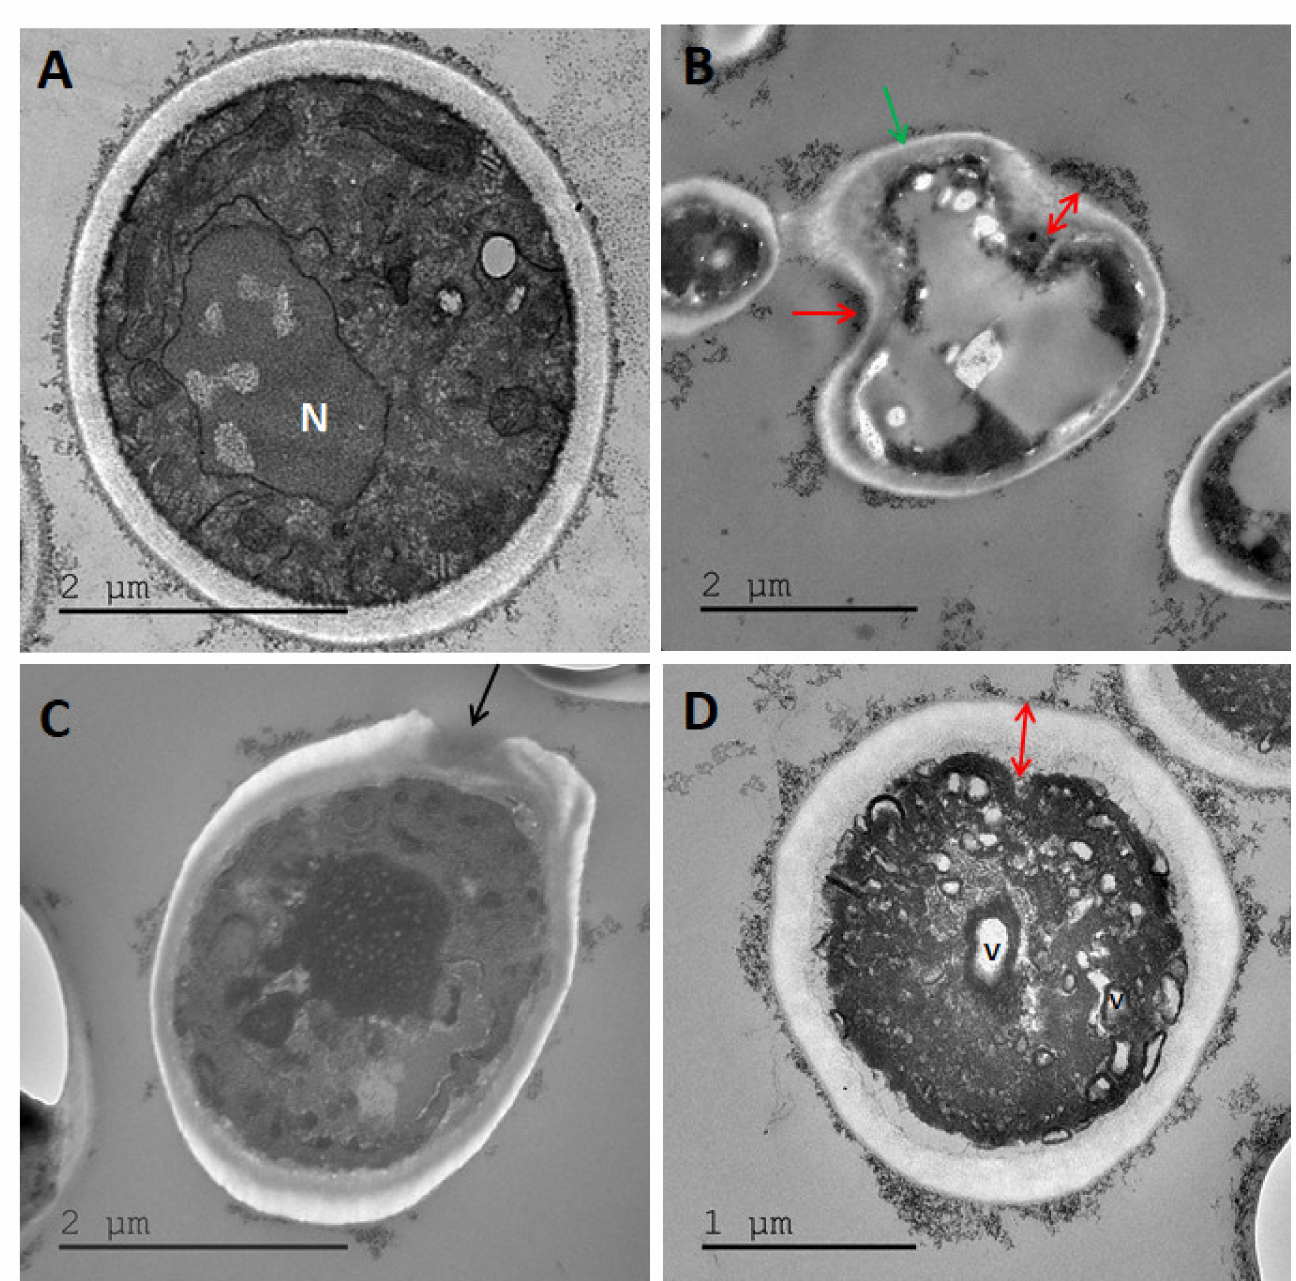
Figure 10. TEM images of Aspergillus brasiliensis treated with ( A ) H 2 0, no treatment control. ( B ) Maltol at 4500 ppm, ( C ) DDAC at 500 ppm, ( D ) blend of maltol and DDAC (95:5) at 5000 ppm. Red arrows: alteration of the cell wall structure, receding of cell membrane and thickening of cell wall. Green arrow: lysis of intracellular material. Black arrow: holes in the cell membrane. N: nucleus, V: